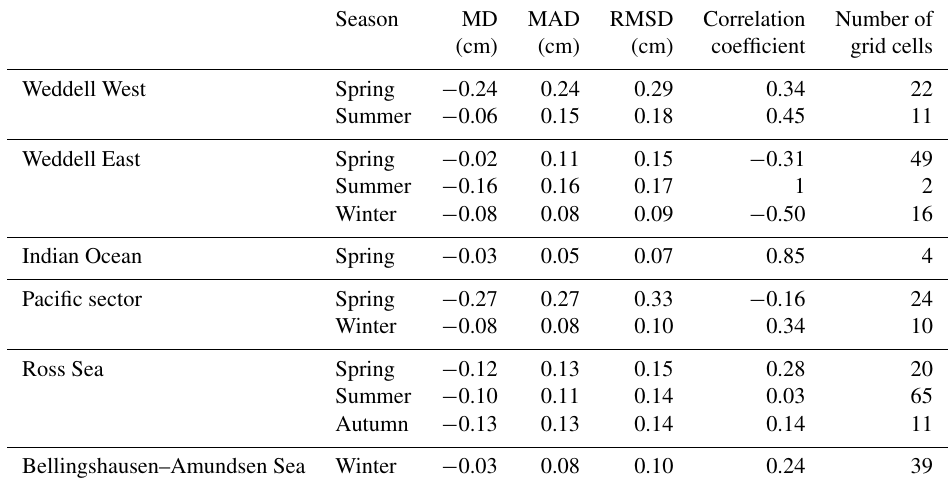
Table 8. The comparisons between the snow depth estimates from the Comiso method and in situ measurements from ASPeCt in different sea sectors and seasons. MD: mean difference; MAD: mean absolute